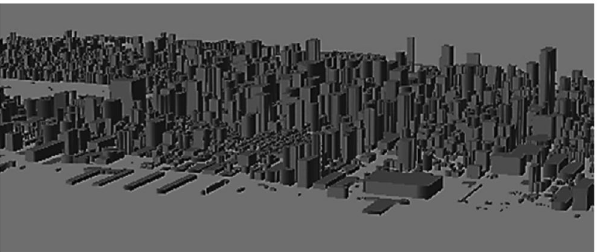
Figure 3. 3D digital surface model of Manhattan used for atmospheric correction and cross referencing of remote sensing with correlative data. (image using